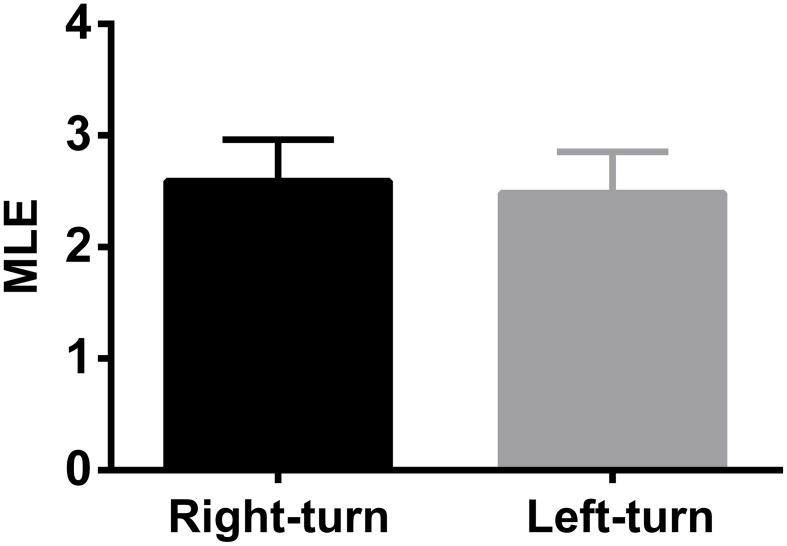
The comparison of MLEs of dynamic trajectories for 20 correct right-turn trials and for 20 left-turn trials. There was no significant difference for the two correct cases (P > 0.05).